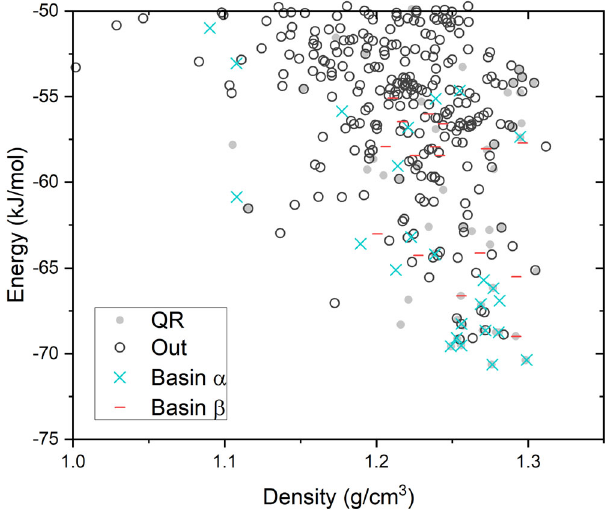
Fig. 6 Lattice energy vs density plot of the landscape of predicted crystal structures of tetrolic acid. Local minima located after optimisation of structures from the threshold sampling are classi fi ed as belonging to either main basins ( α and β ) or not within one of these basins (black circles, labelled 'Out'). Crystal structure prediction results from quasi-random sampling (QR) are shown for comparison, with searches performed in space groups P 1 and P 2 1 .